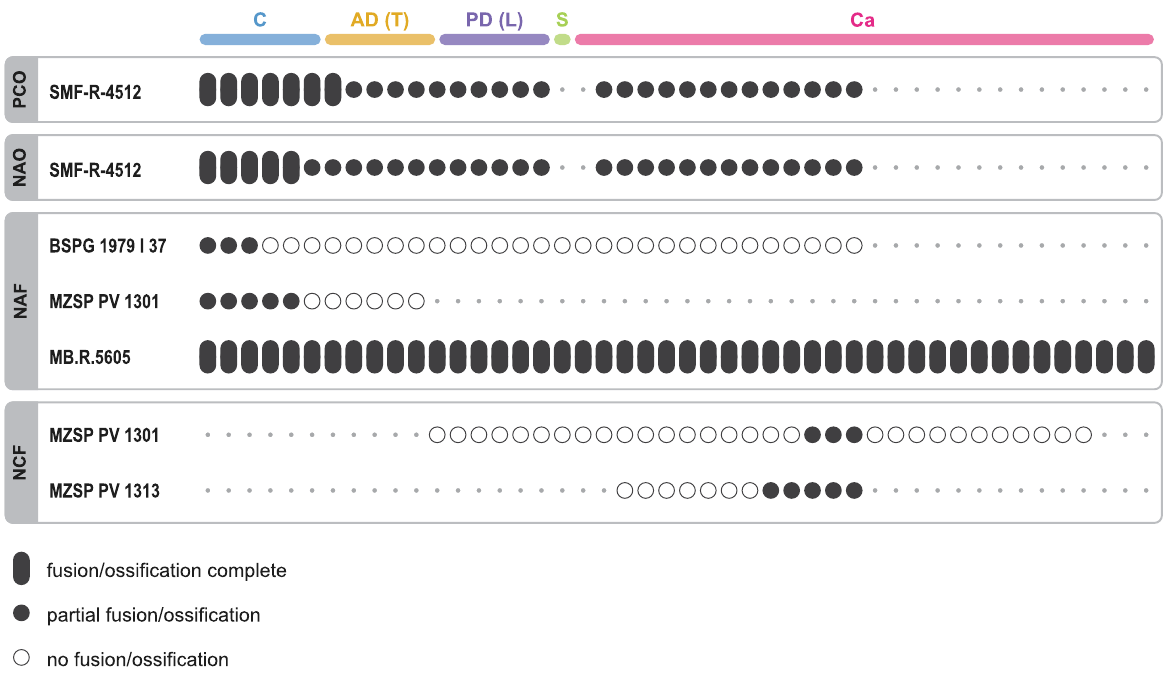
Figure 3. State of advancement of axial ossification patterns in juvenile Mesosaurus tenuidens . Each oval/ circle represents two vertebrae. PCO pleurocentrum ossification, NAO neural arch ossification, NAF neural arch fusion, NCF neurocentral fusion. Vertebral sections are labelled as follow: C cervicals, AD anterior dorsals (scored as T in Table S1); PD posterior dorsals (scored as L in Table S1), S sacrals, C a